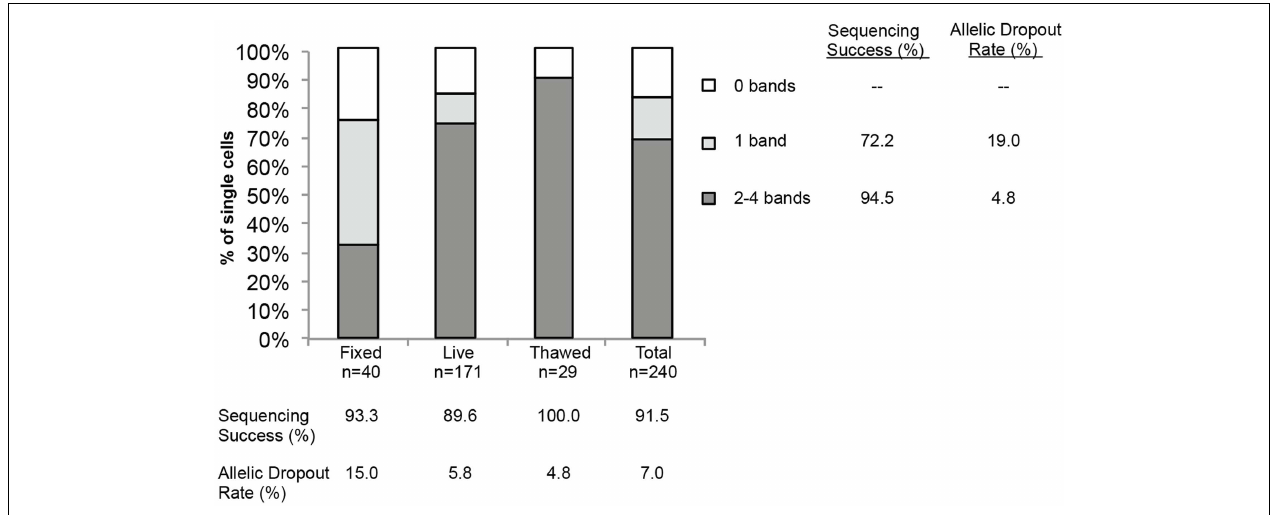
height of each bar represents the percentage of cells with 2–4 (dark grey), 1 (light grey), or 0 bands (white) on the Q/C gel. Shown at right and below the graph are the sequencing success rates for all 240 tumor cells and WBCs by category, as well as the allelic dropout rate for the 110 tumor cells sequenced.